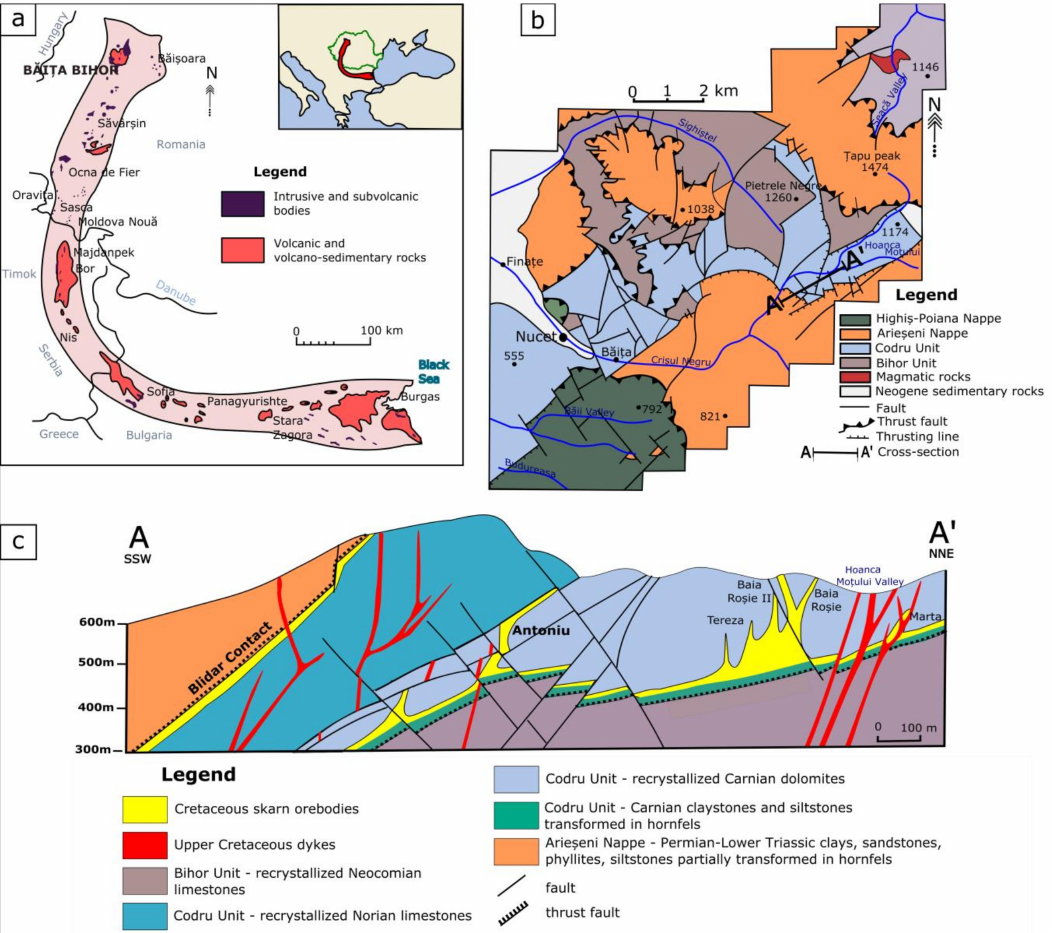
Figure 1. The location and geology of the B ă it Magmatic and Metallogenetic Belt in SE Europe and the location of B ă it Cioflic ă and Vlad [24]); ( b ) simplified geology of the B ă it B ă it a-Bihor ore deposit along cross-section A-A’ line indicated on ( b ) showing the location of the main , orebodies